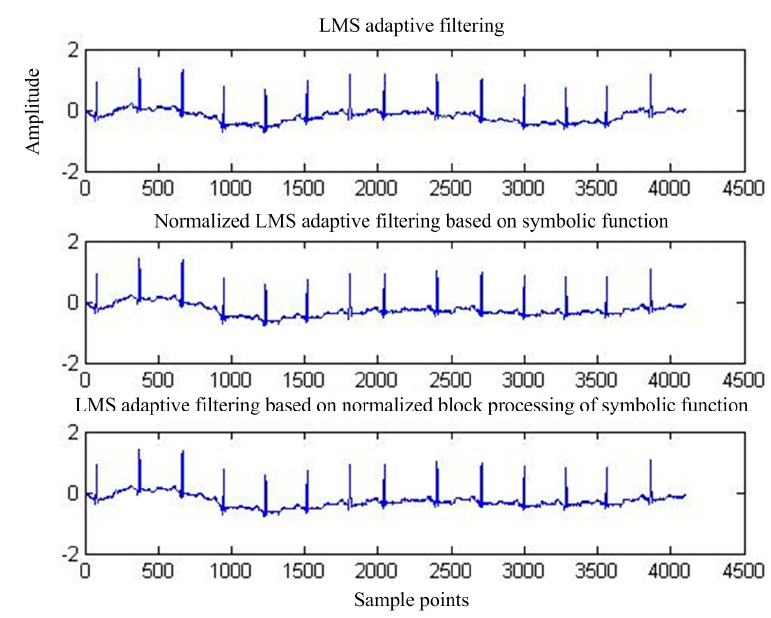
Figure 15. Output MIT-BIH signal after adaptive interference cancellation.